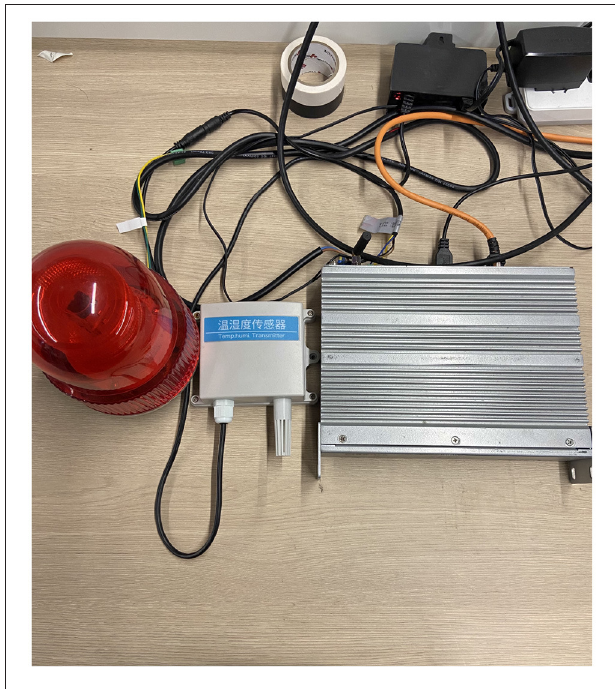
FIGURE 8 | Gateway.